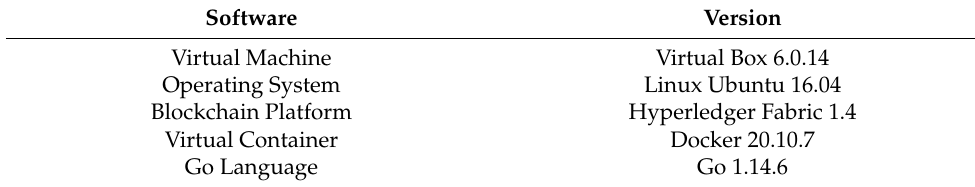
Table 6. Hyperledger fabric software environment.